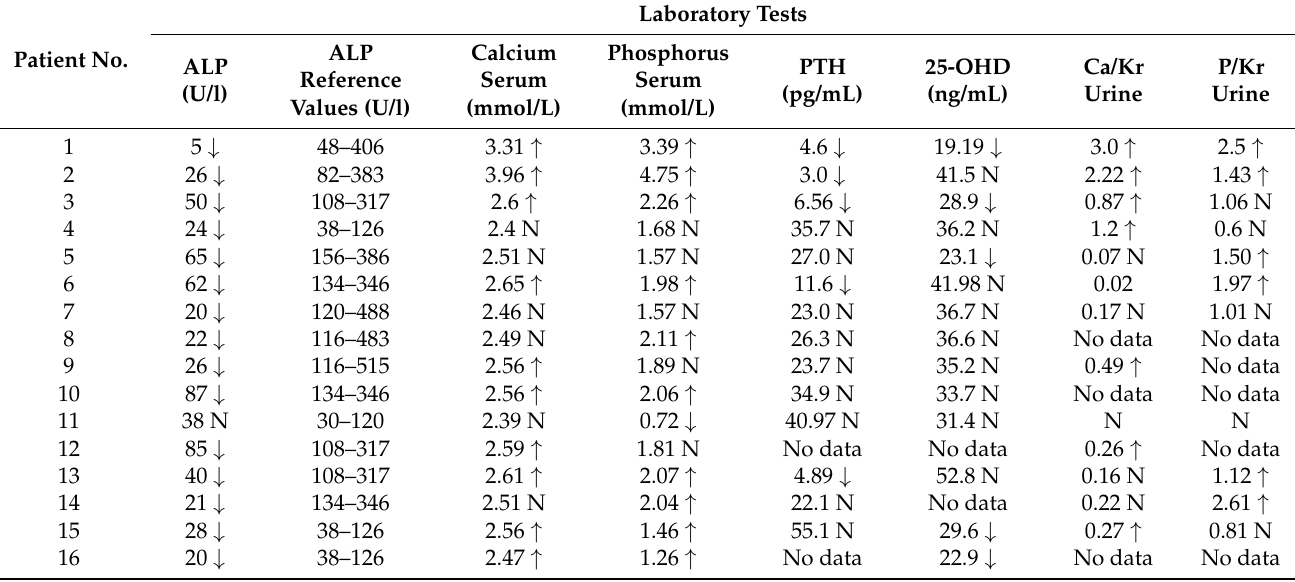
Table 2. Results of laboratory (biochemical and hormonal) tests in all the patients included in the